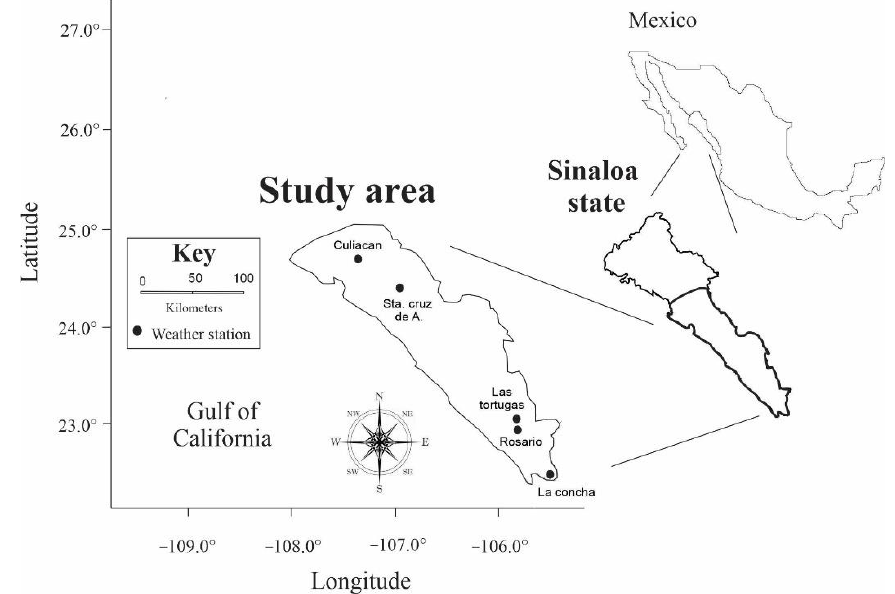
Figure 1. Study area, located in northwestern